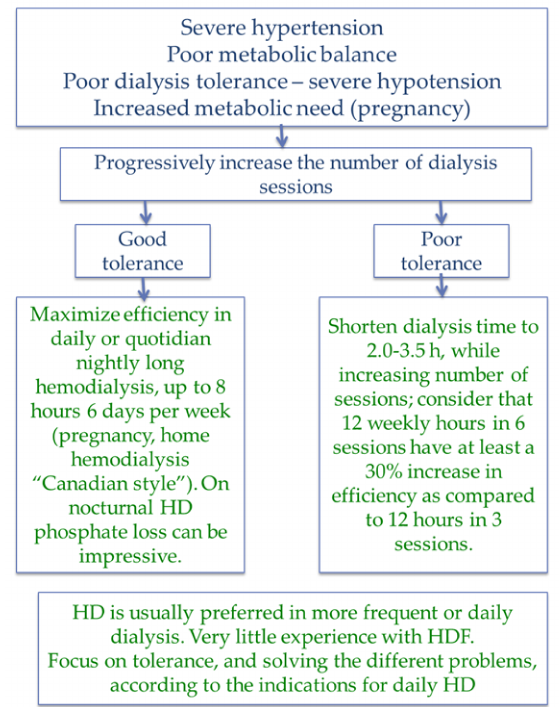
Figure 7. Daily and more efficient